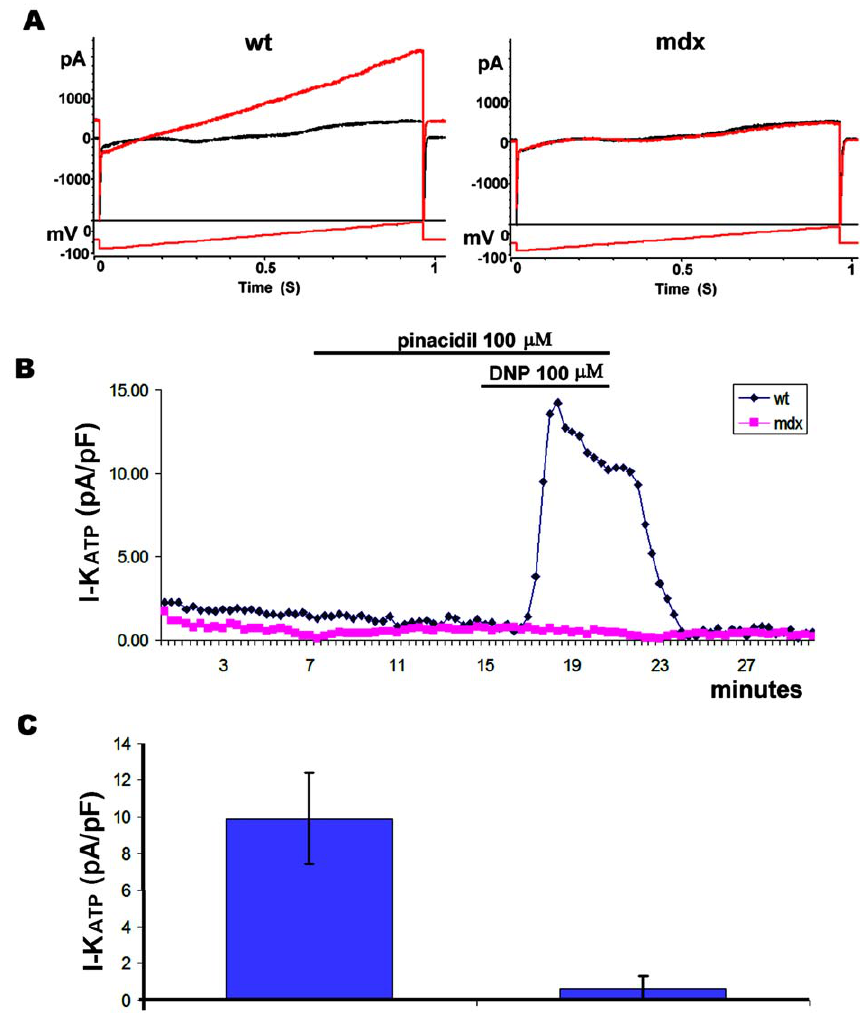
Figure 4. Current recorded from adult cardiomyocytes. A) Wt and mdx traces primed with 100 m M Pinacidil, before and after application of DNP 100 m M in voltage clamp whole cell configuration. The voltage protocol used to elicit the current is also indicated. The red trace shows the current after 5 minutes of DNP application. B) Time course of a recording from wt and mdx cells in relation to the timing of Pinacidil and DNP application. C) K ATP current quantified from the recording of 9 wt (from 3 mice) and 12 mdx (from 4 mice) cells. The current was normalized to the cell